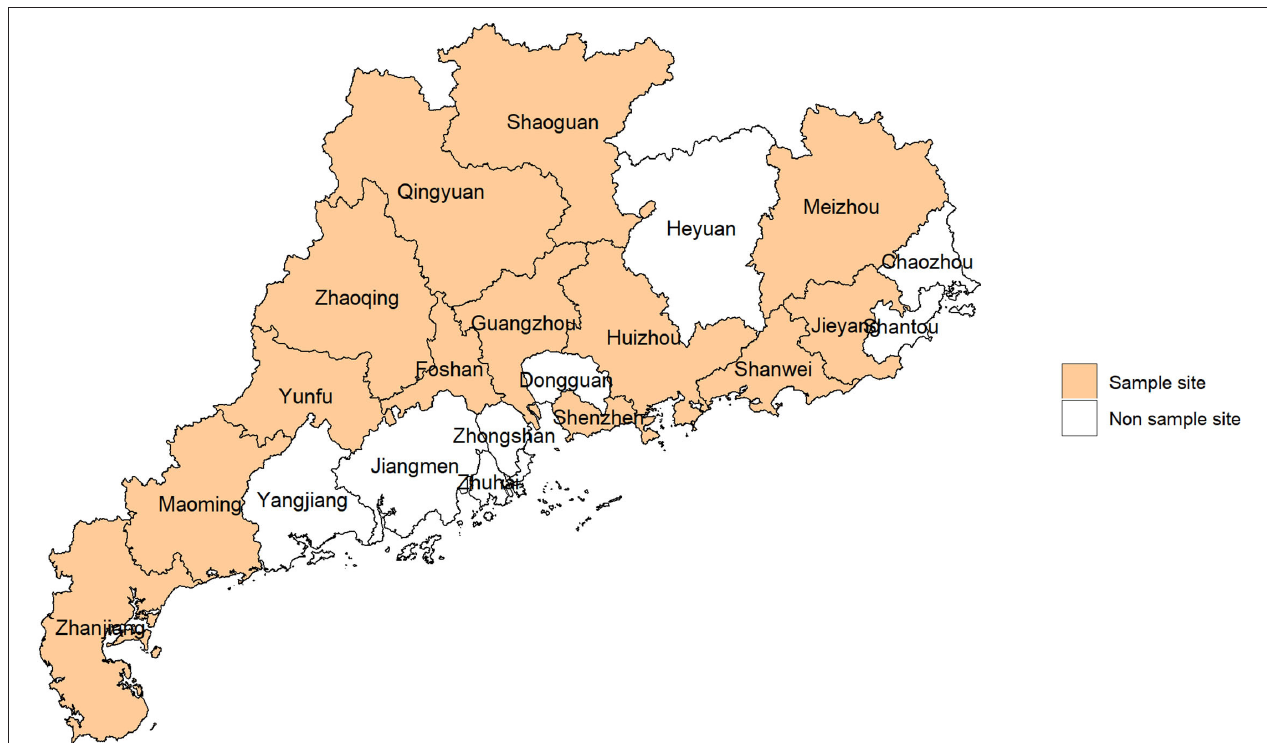
FIGURE 1 | Sample sites in this